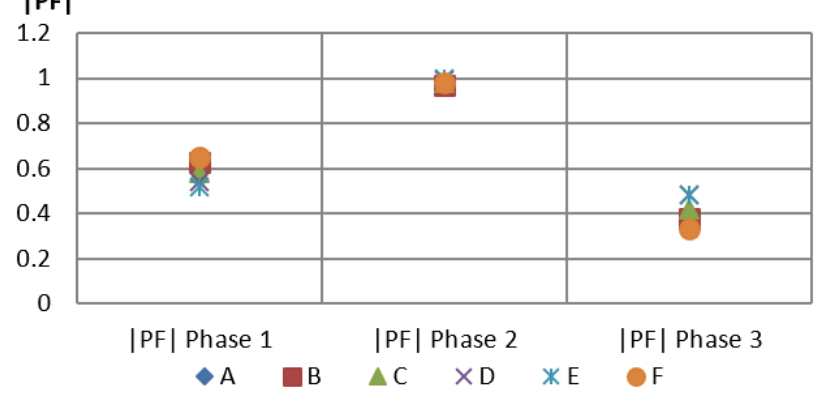
Figure 7. Fast charger’s power factor per phase, during charging at ambient temperature.